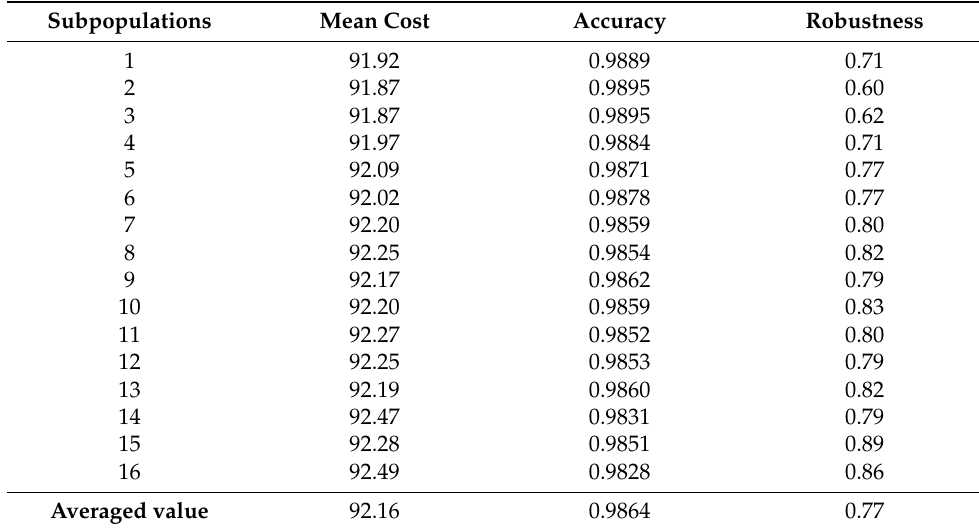
Table 11. Cross-section under biaxial bending. LSRD and GSRD. Performance metrics.